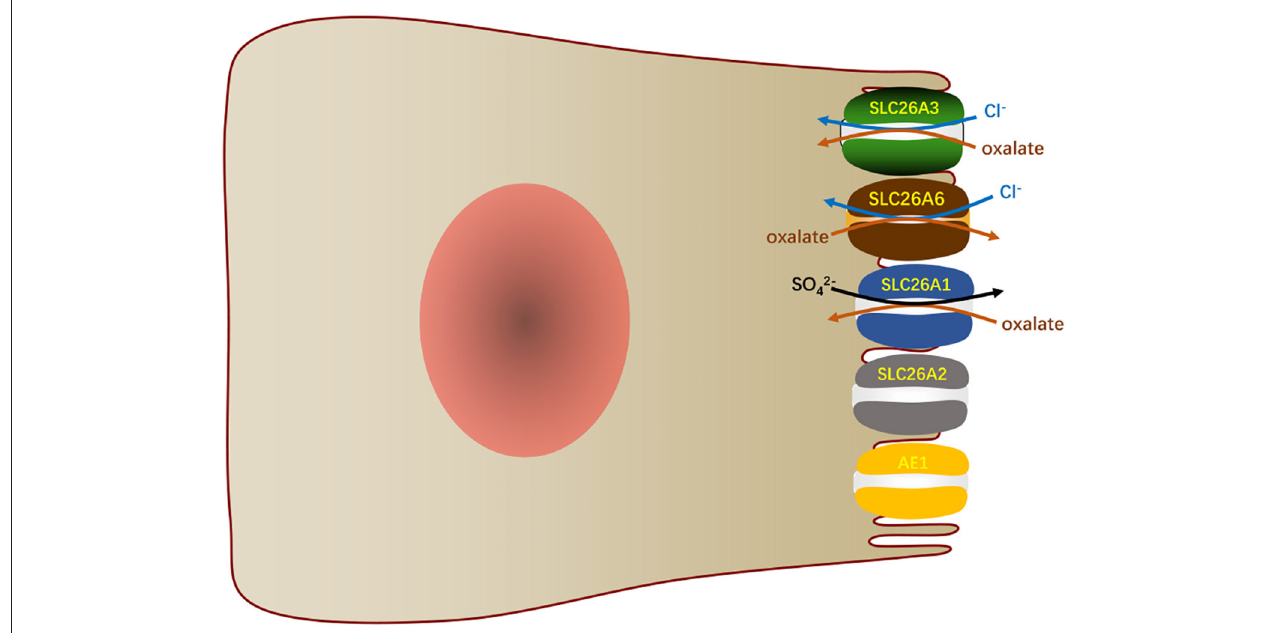
FIGURE 5 | In the small intestinal villi epithelium, SLC26A6 and other transports participate in the oxalate